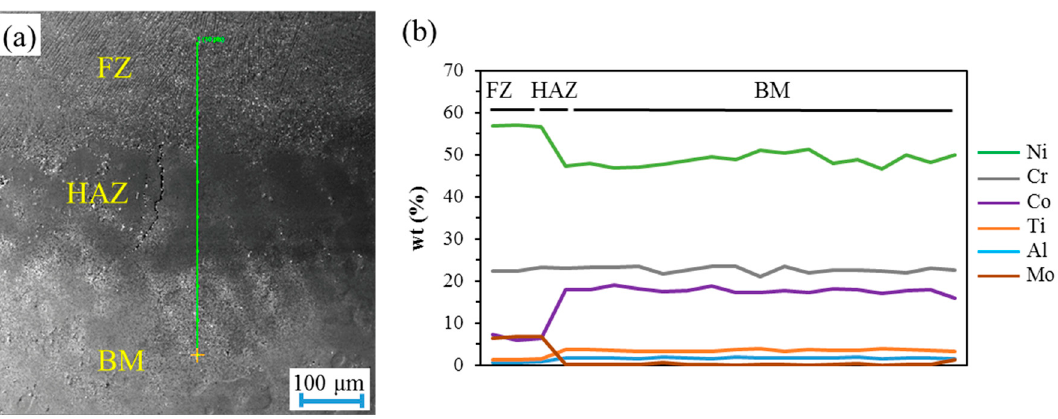
Figure 11. EDS line analysis of A1 welded specimen in the welding zone; ( a ) SEM photo and ( b ) changes in the chemical composition in the three welding